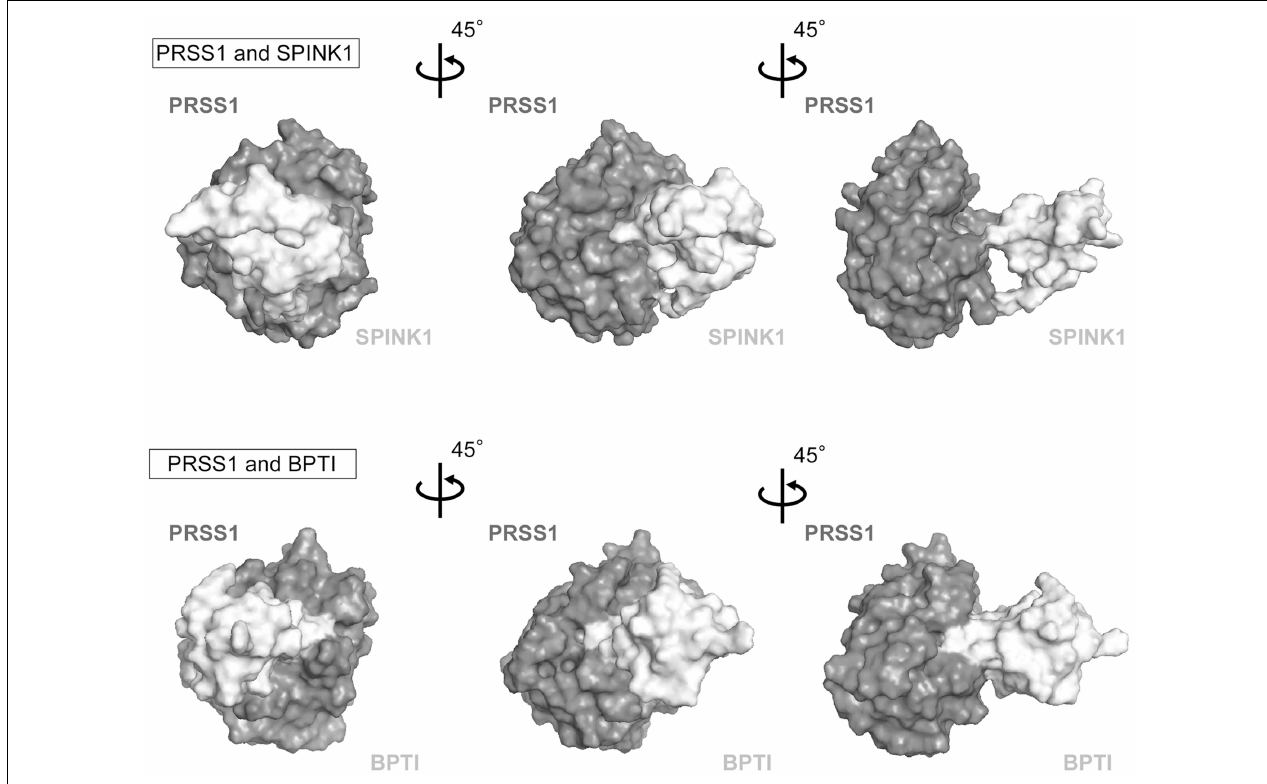
atoms were added to these structures by using PyMOL software. Molecular docking simulations for PRSS1 and SPINK1 were the carried out by using